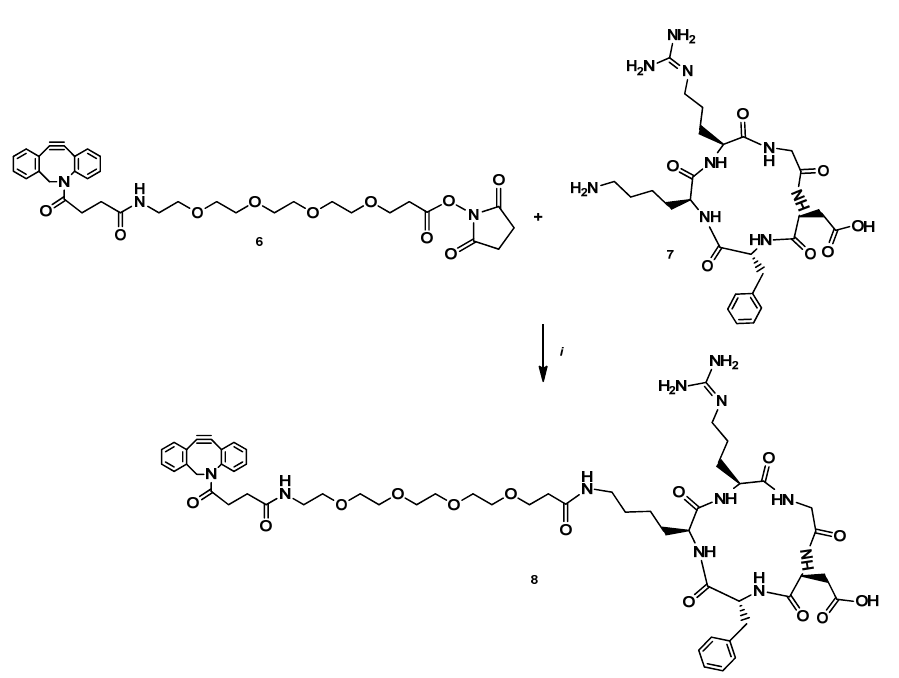
Figure 3. Reagents and conditions: (i) DIPEA, DMSO, rt, 24 h, 44.5%.